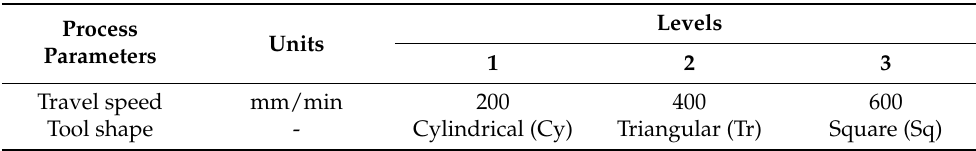
Table 3. Process parameters and their